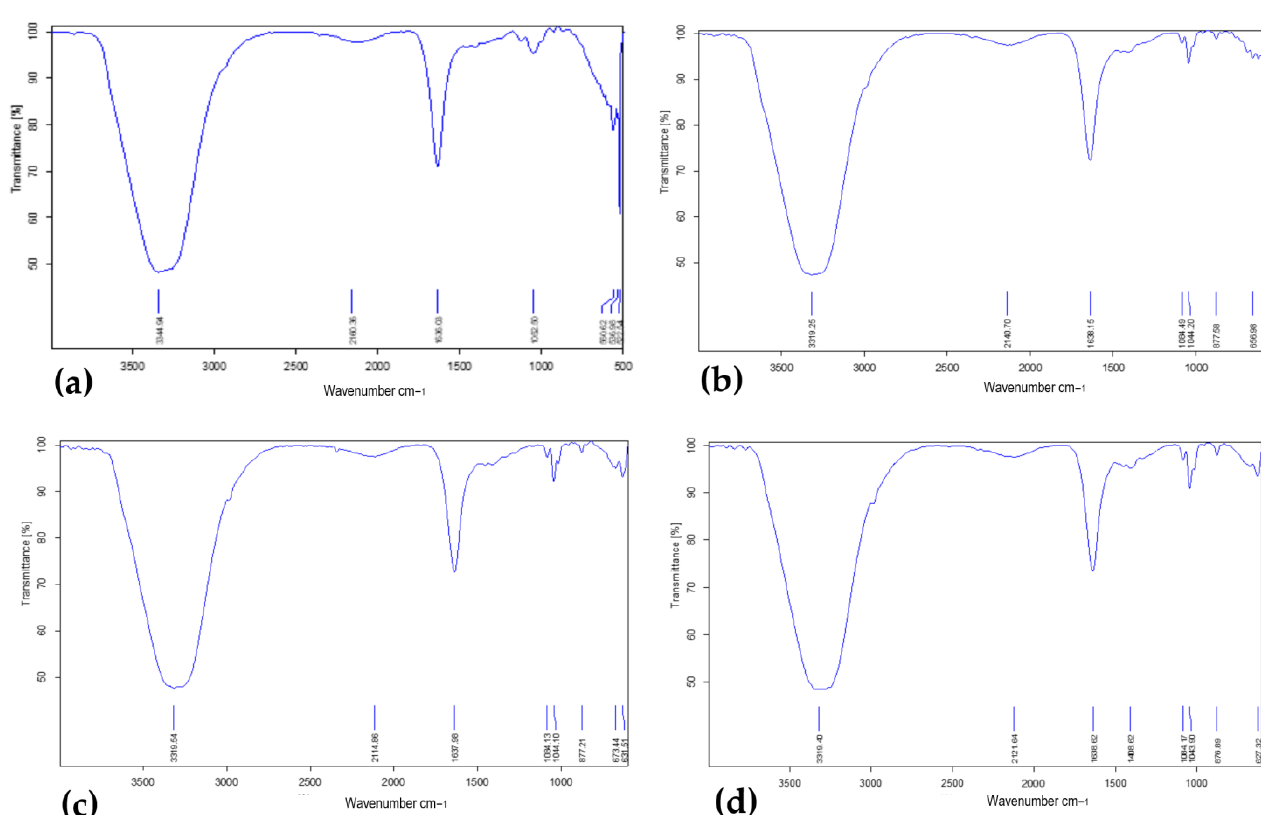
Figure 4. FTIR spectra of ( a ) Onion extract. ( b ) Bioethanol from S. cerevisiae. ( c ) Bioethanol from P. pastoris. ( d ) Bioethanol from Co-culture strain.